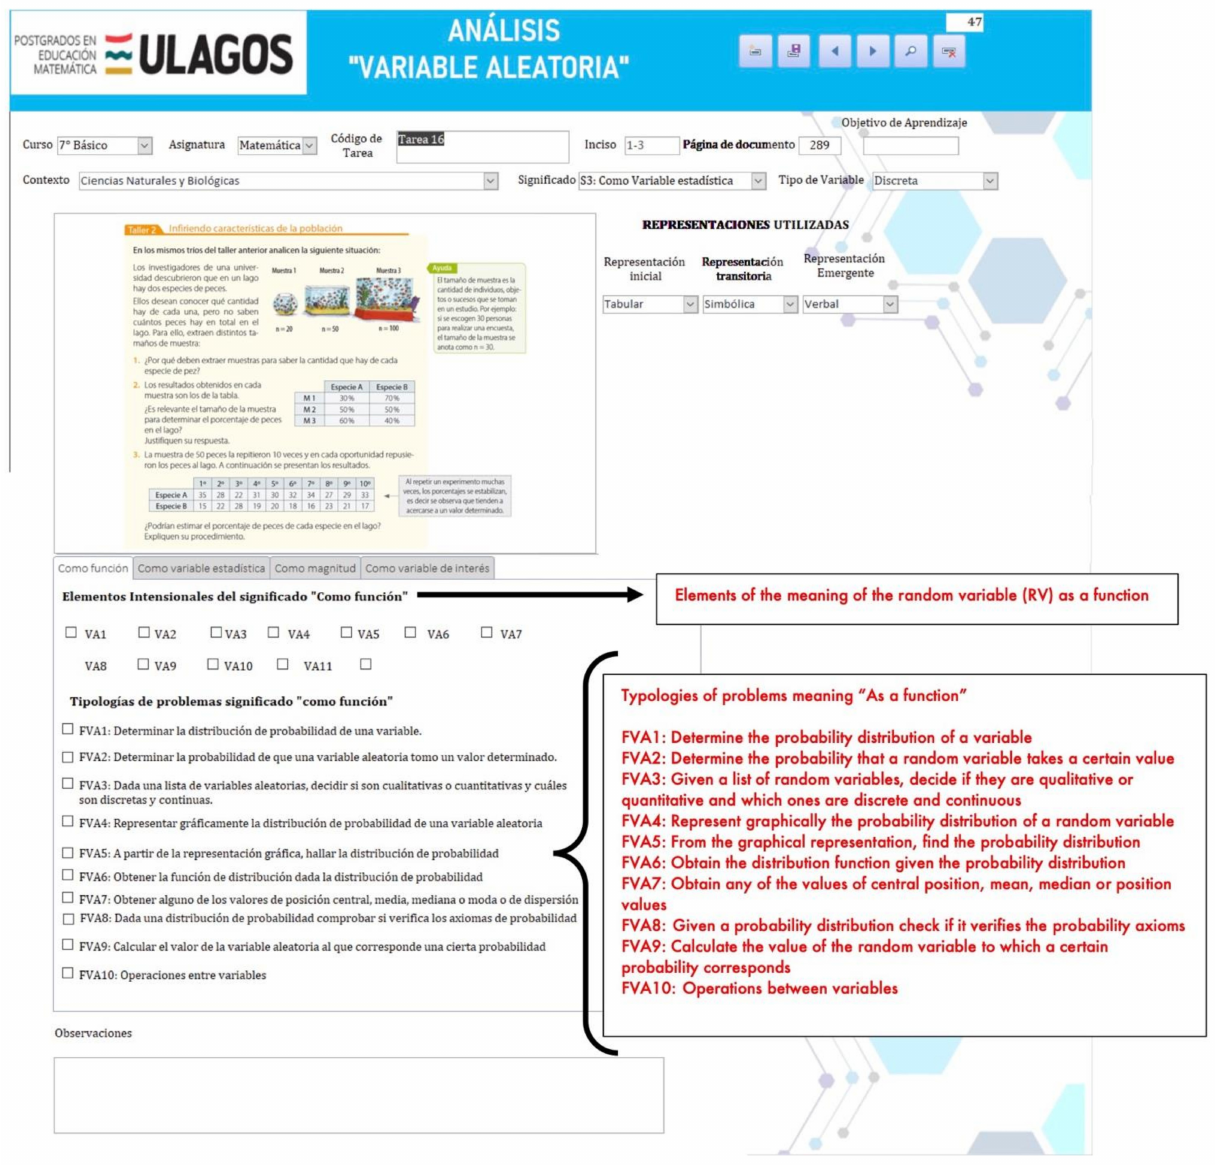
Figure 3. Analysis interface (Source: Prepared by the